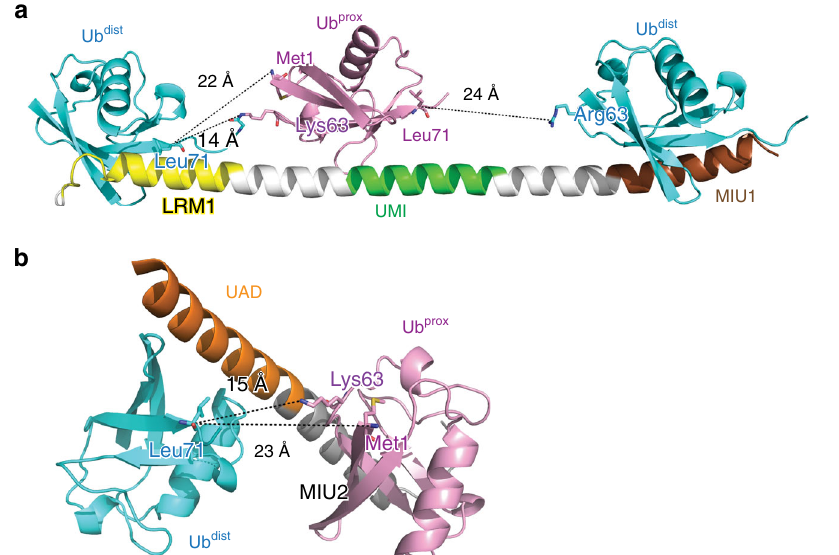
Fig. 4 Spacing between Ub dist and Ub prox of K63-Ub 2 bound to UDM1 or UDM2 Δ C of RNF168. a Spacing between Ub dist and Ub prox of K63-Ub 2 bound to UDM1 of RNF168 in the form I crystal. The coloring scheme is the same as in Fig. 2. b Spacing between Ub dist and Ub prox of K63-Ub 2 bound to UDM2 Δ C of RNF168. Same coloring scheme as in Fig.